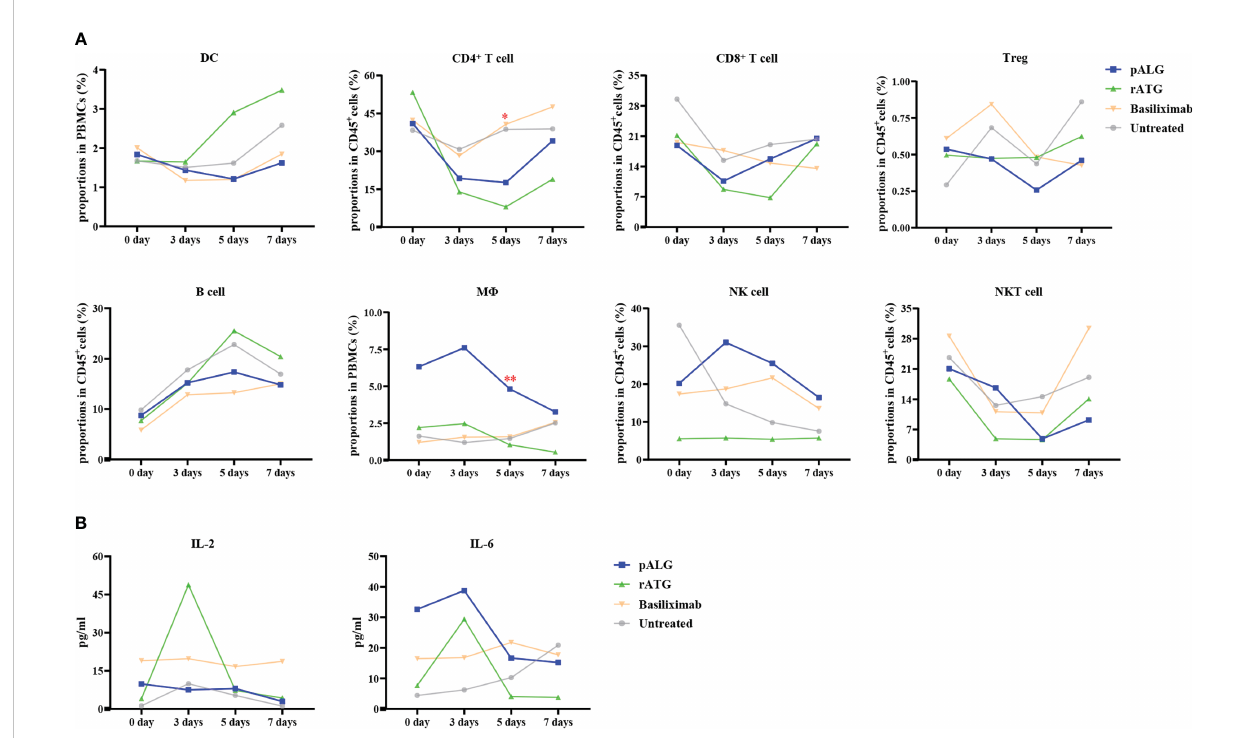
FIGURE 5 Recipients ’ immune cell populations after kidney transplantation. (A) Proportions of DC, CD4 + T cell, CD8 + T cell, Treg, B cell, M f , NK cell and NKT cell in PBMCs or CD45 + T cells at 0 day, 3 days, 5 days and 7 days. M f , macrophage. (B) Serum levels of IL-2 and IL-6. (*p<0.05,